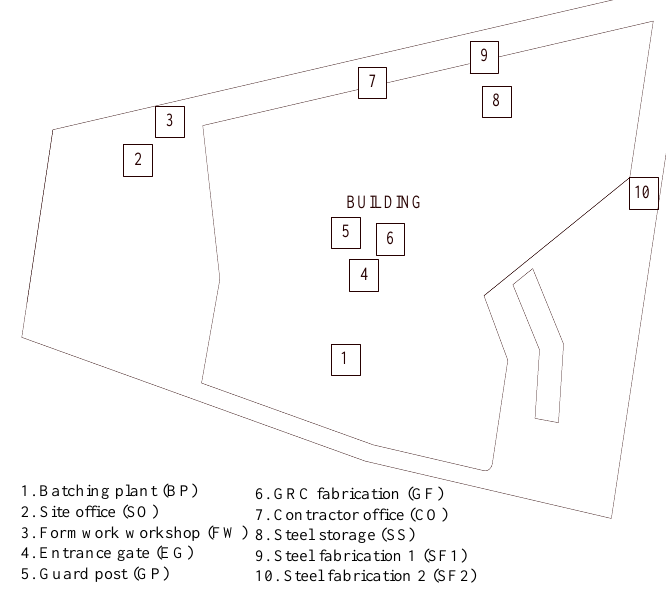
Figure 8. Site Layout for Case 3.